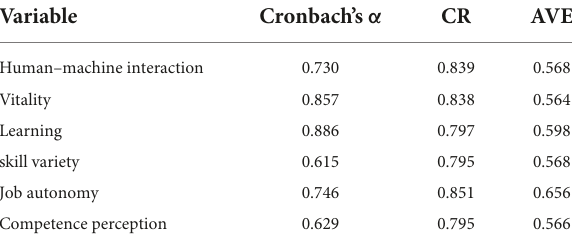
TABLE 1 Variable reliability and convergent validity.